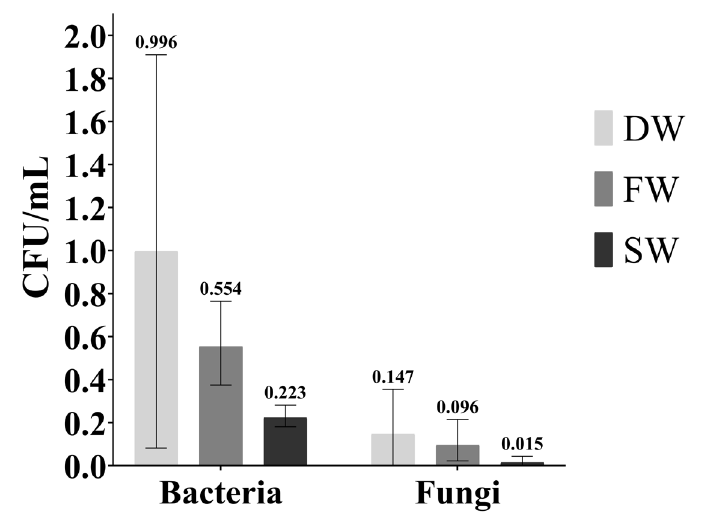
mean of colony forming units (CFU) per milliliter of waterborne bacteria and fungi found in the rodent facility. DW, drinking water; FW, filtered water; SW, sterile